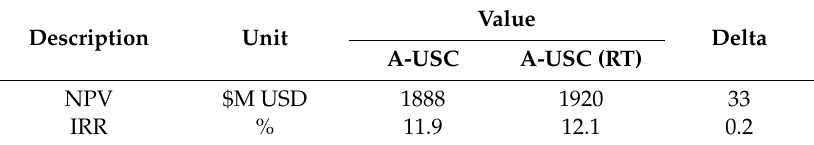
Table 10. NPV and IRR comparison of A-USC with and without RT assuming $1,409 M initial investment.